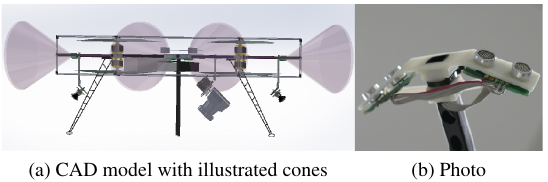
Figure 7: Setup and mounting of ultrasonic sensors.